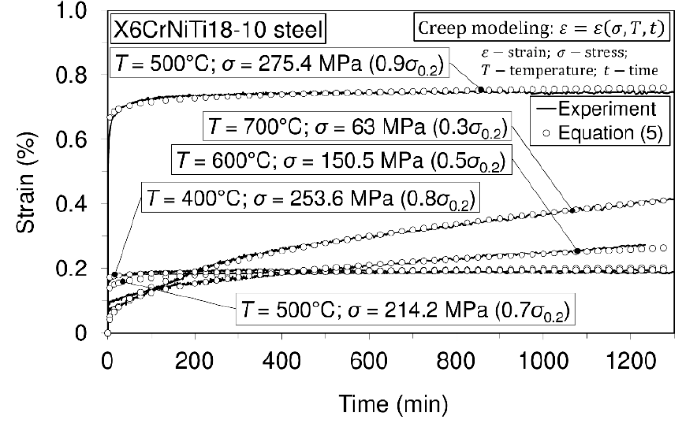
Table 2. Creep modeling data: X6CrNiTi18-10 steel. Material: X6CrNiTi18-10 steel